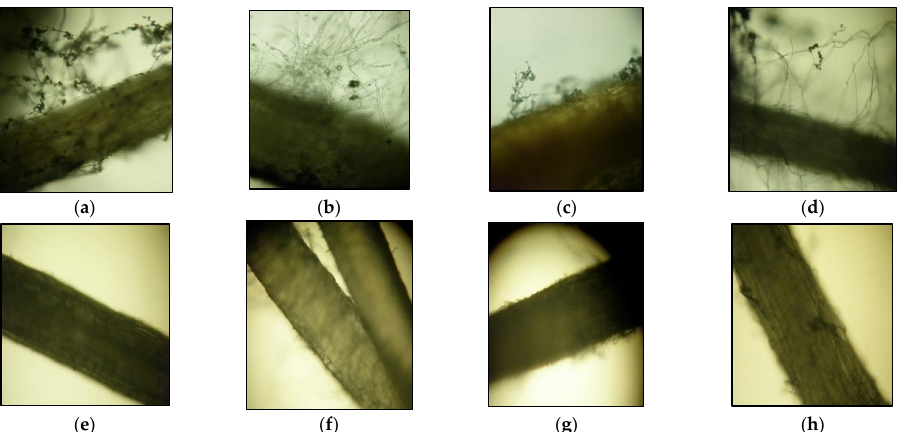
Figure 3. Roots of the four Italian tetraploid durum wheat seedlings deriving from seeds treated with Trichoderma harzianum T-22 ( a – d ) or untreated ( e – h ): Ciclope ( a , e ), Creso ( b , f ), Saragolle Lucana ( c , g ), and Simeto ( d , h ) (resolution 20×).